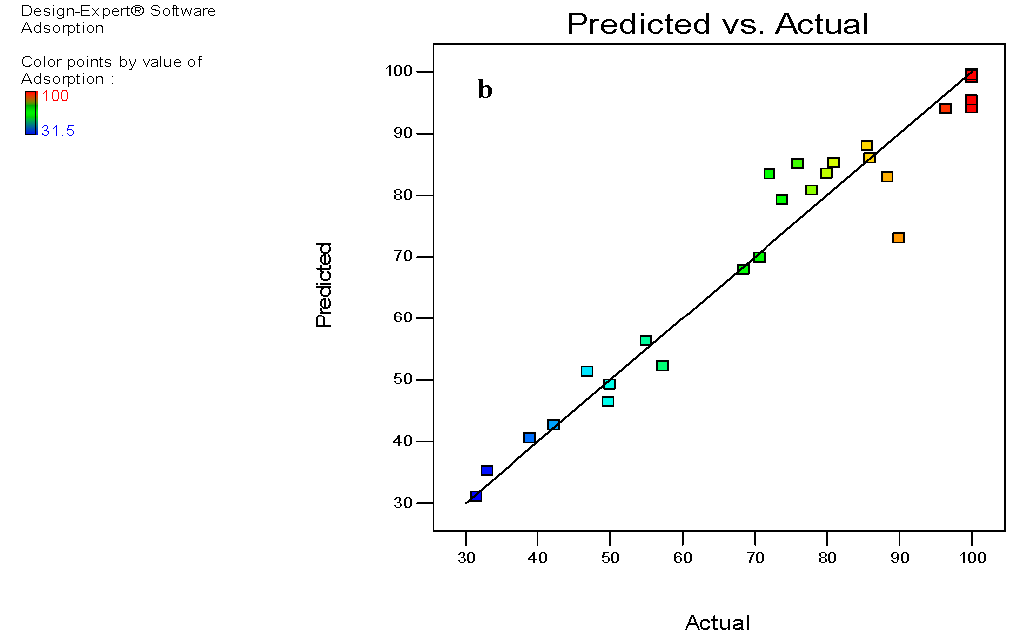
Figure 6. Normal percent probability versus internally Studentized residuals ( a ) and comparison of model predictions of adsorption with the experimental data ( b ) ( R 2 = 0.899).